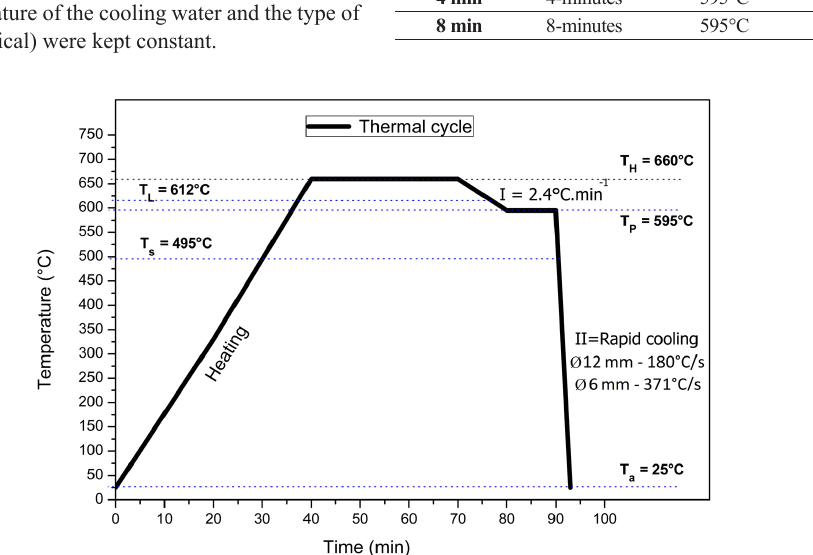
-Overheating temperature; T H